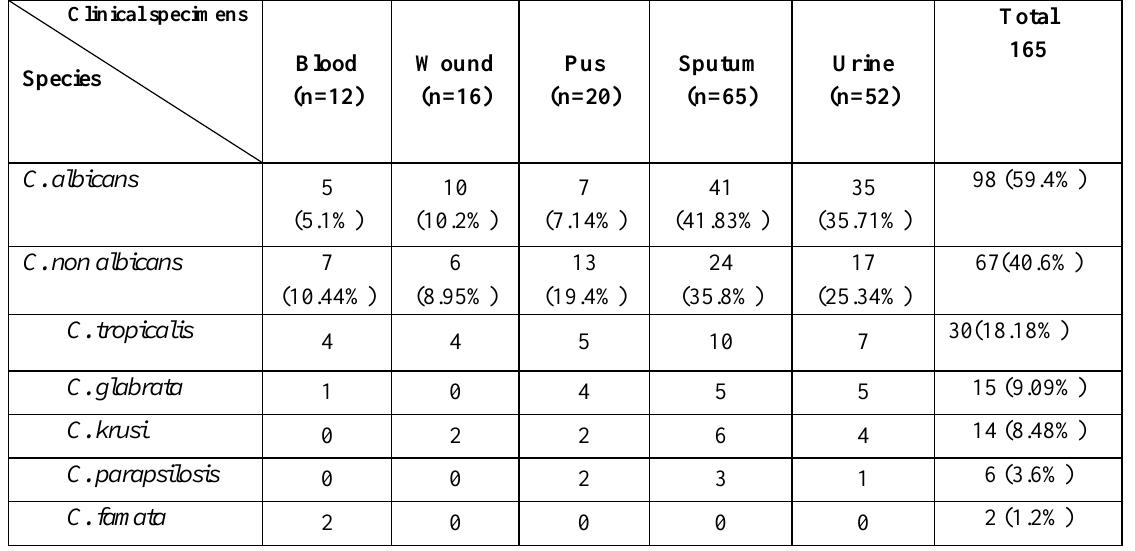
Table 2. Distribution of Candida species in different clinical